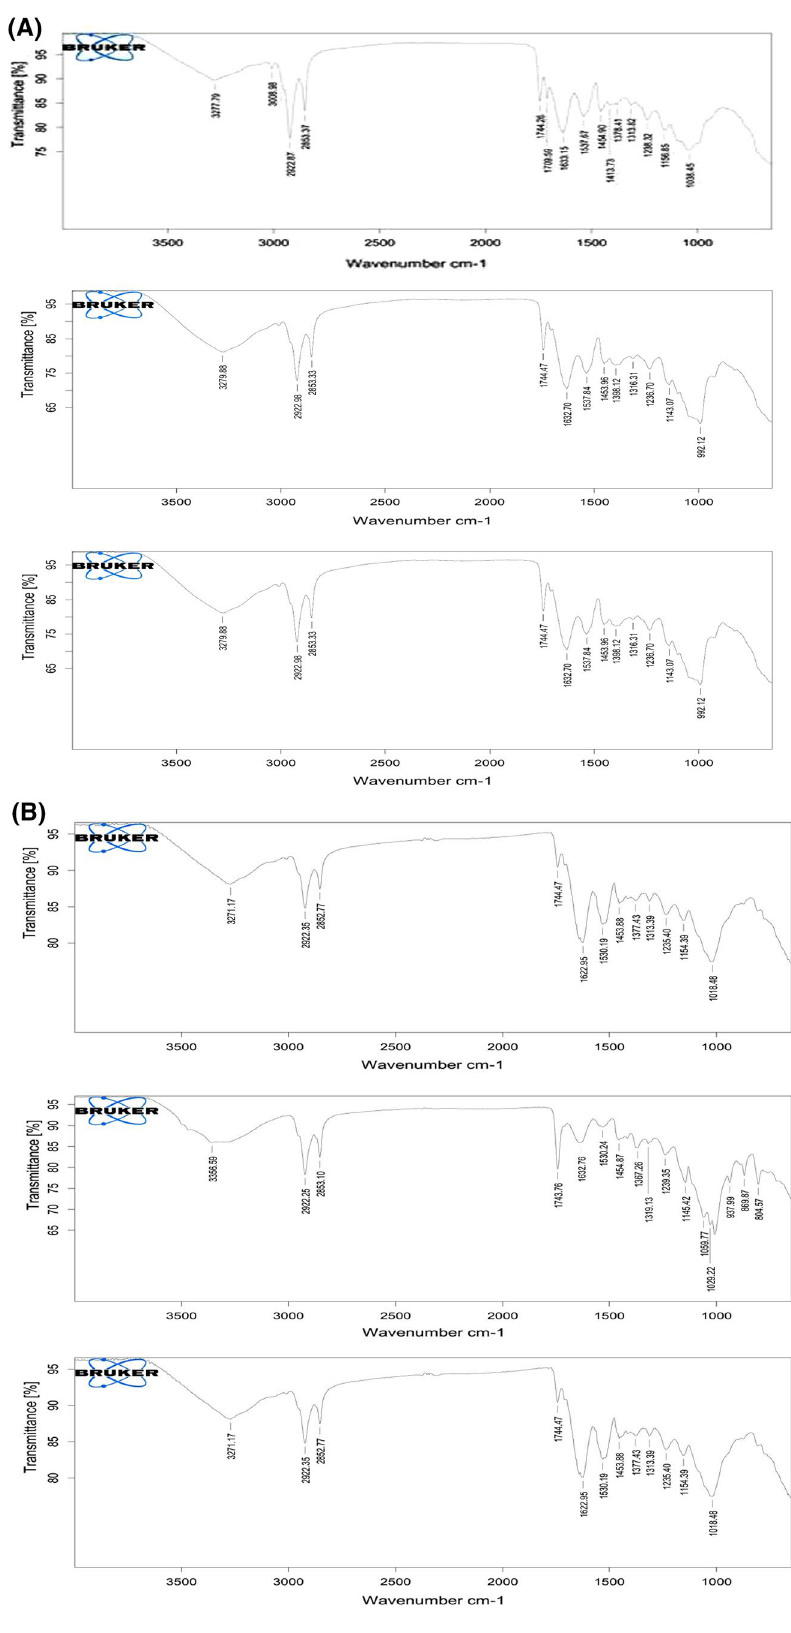
Fig. 2 a FTIR spectra of the adsorbents before adsorption, b FTIR spectra of the adsorbents after